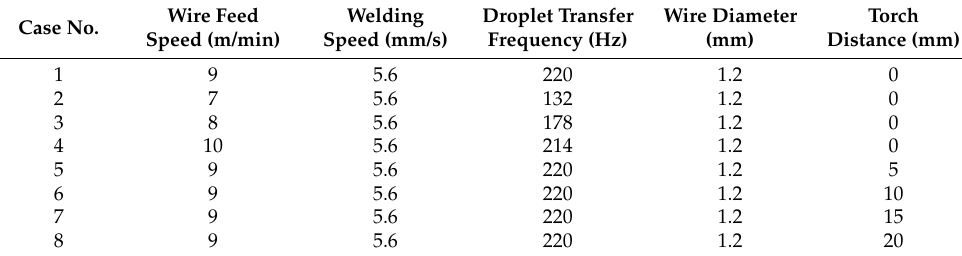
Table 1. Welding parameters included in different welding conditions. Case